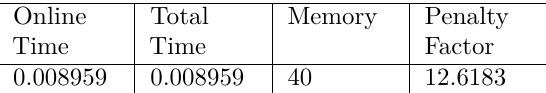
Table 9: Second-order S-box implementation of PRESENT using the second-order circuit based scheme [CRV15] with three input shares. The execution times are in seconds. The memory required is in